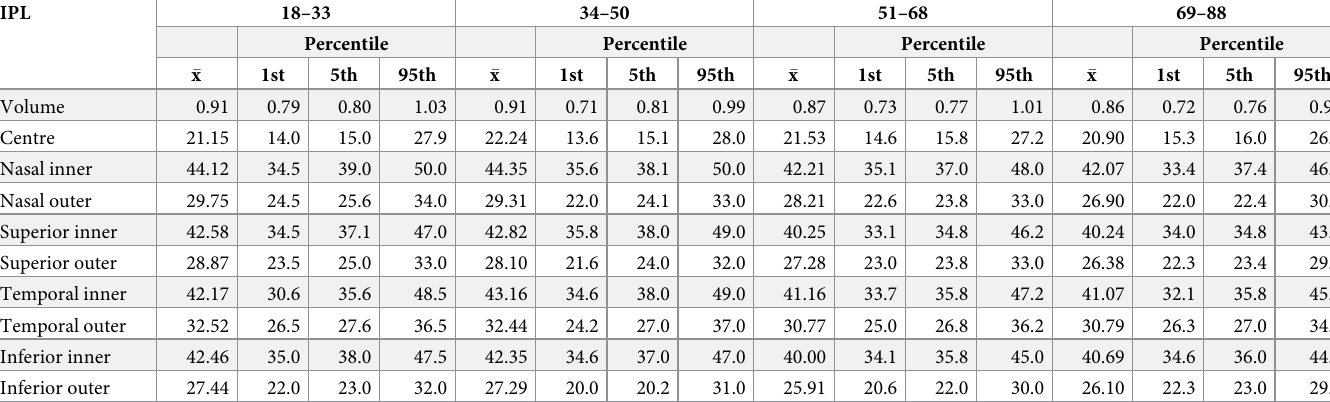
Table 7. Macular inner plexiform layer thickness distribution by age group, showing mean, first, fifth and 95th percentile values for each segment. IPL